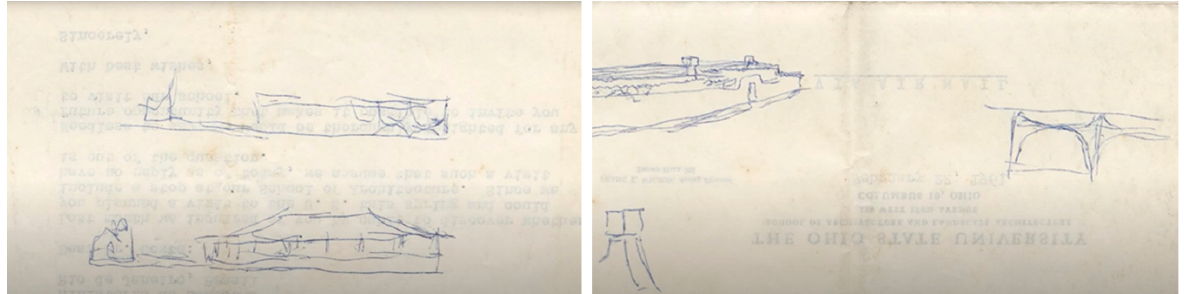
Figure 8. Lúcio Costa, Sketches on the back of a letter sent from Ohio State University, courtesy of archive of IPHAN, Rio de Janeiro.